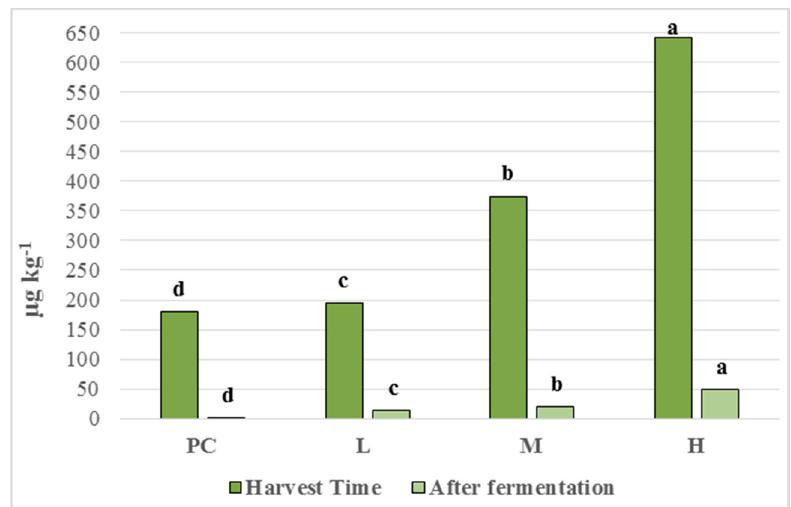
Figure 3. Selenium content in Gordal olive samples at harvest and after fermentation. Lowercase letters show differences by Tukey’s multiple range test among the samples for each studied period (at harvest time and after fermentation).